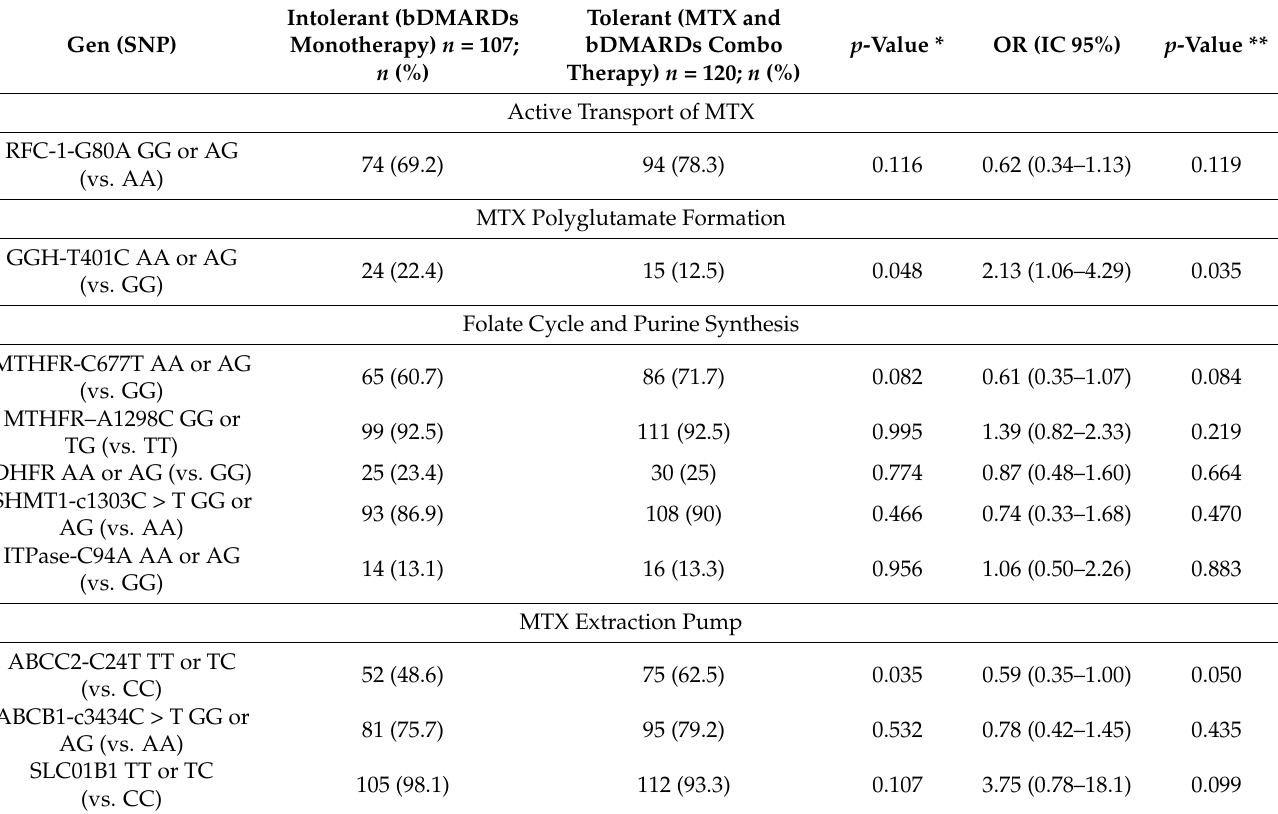
Table 3. Univariate logistic regression to evaluate the association between MTX intolerance and genetic